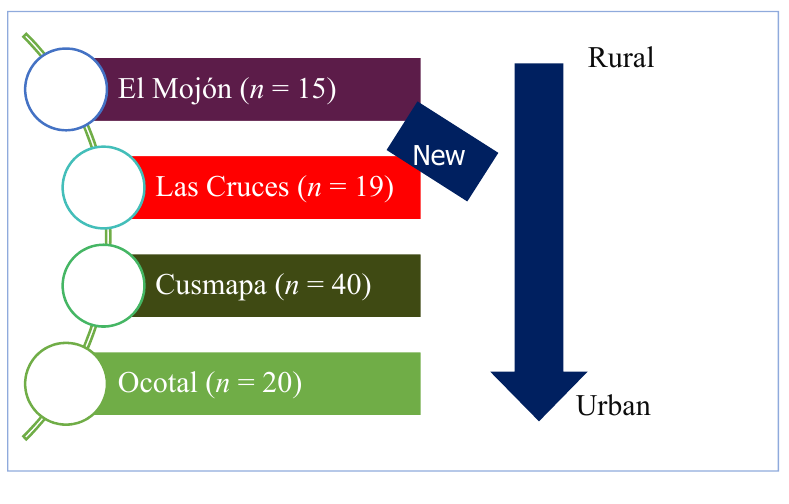
Figure 3. 4-S Clubs That Participated in the Study